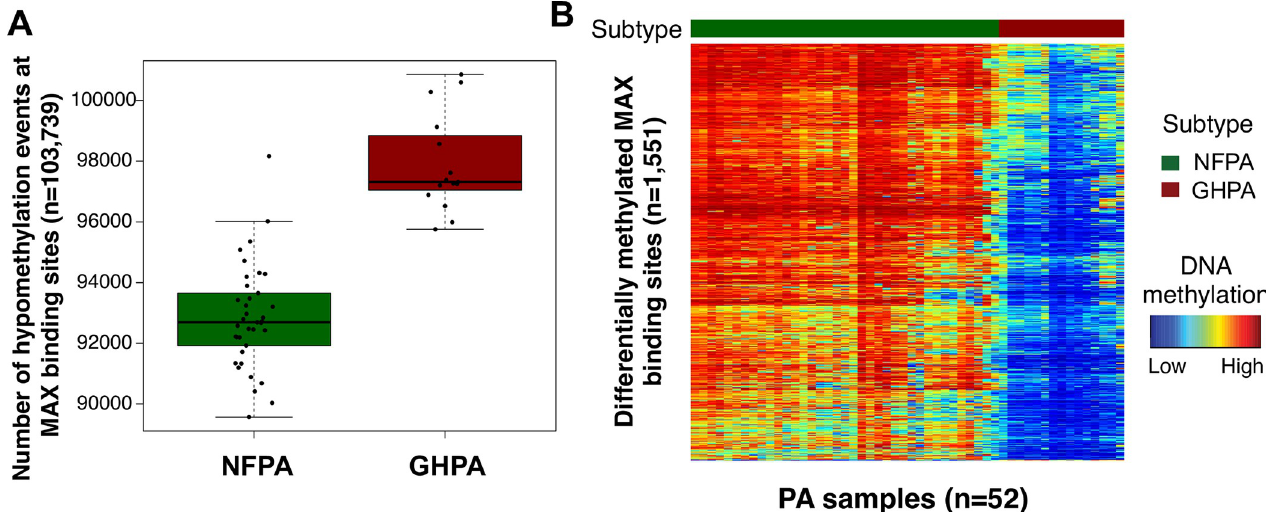
Fig 2. MAX binding sites are hypomethylated in GH-secreting PA compared to Non-functional PA. (A) Number of hypomethylated MAX binding sites in NFPA (n = 37) vs GHPA (n = 15) (p < 1.22e-10). (B) Heat map displaying loci of differentially methylated MAX binding sites between NFPA and GHPA (p < 0.05) (n = 13